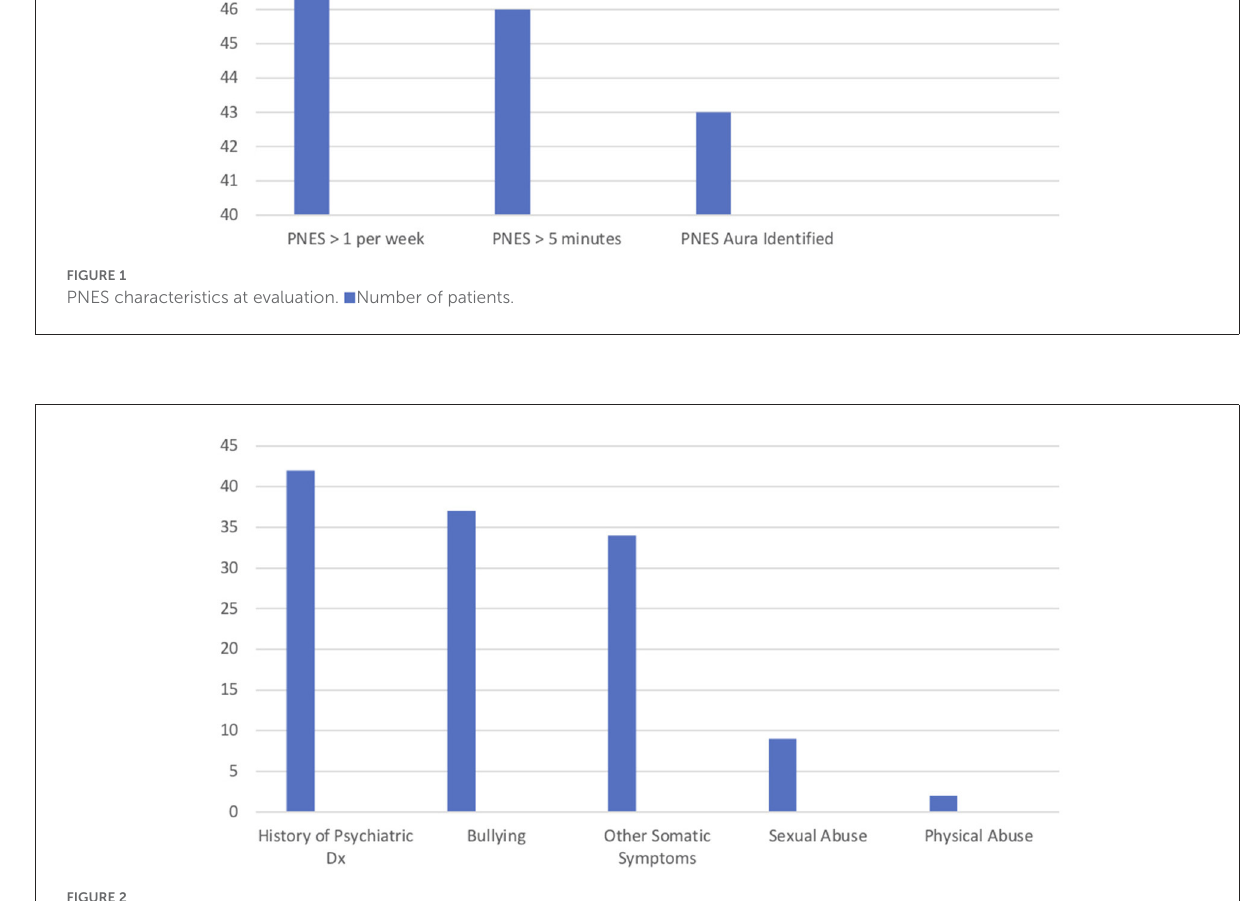
FIGURE2 PNES patient risk factors. Number of patient’s with risk